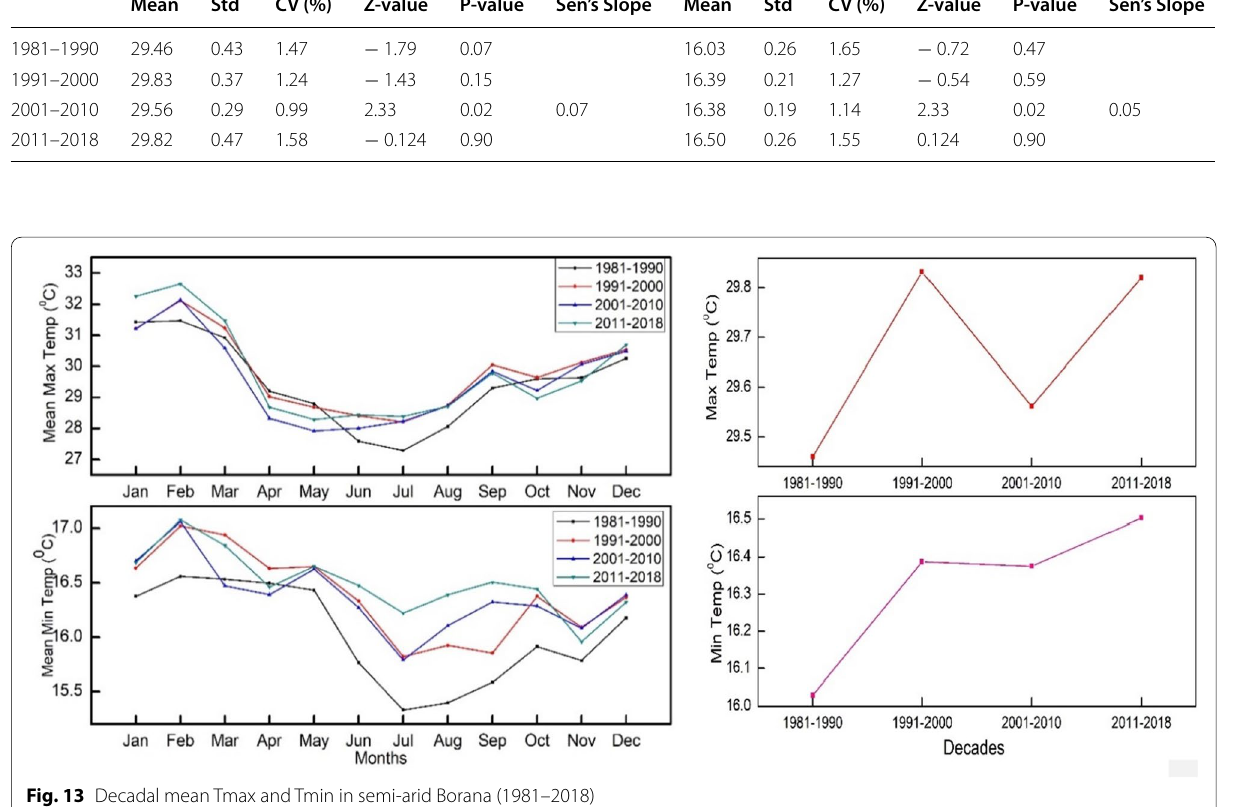
Table 8 Decadal Tmax and Tmin in the study area (1981–2018) Decades